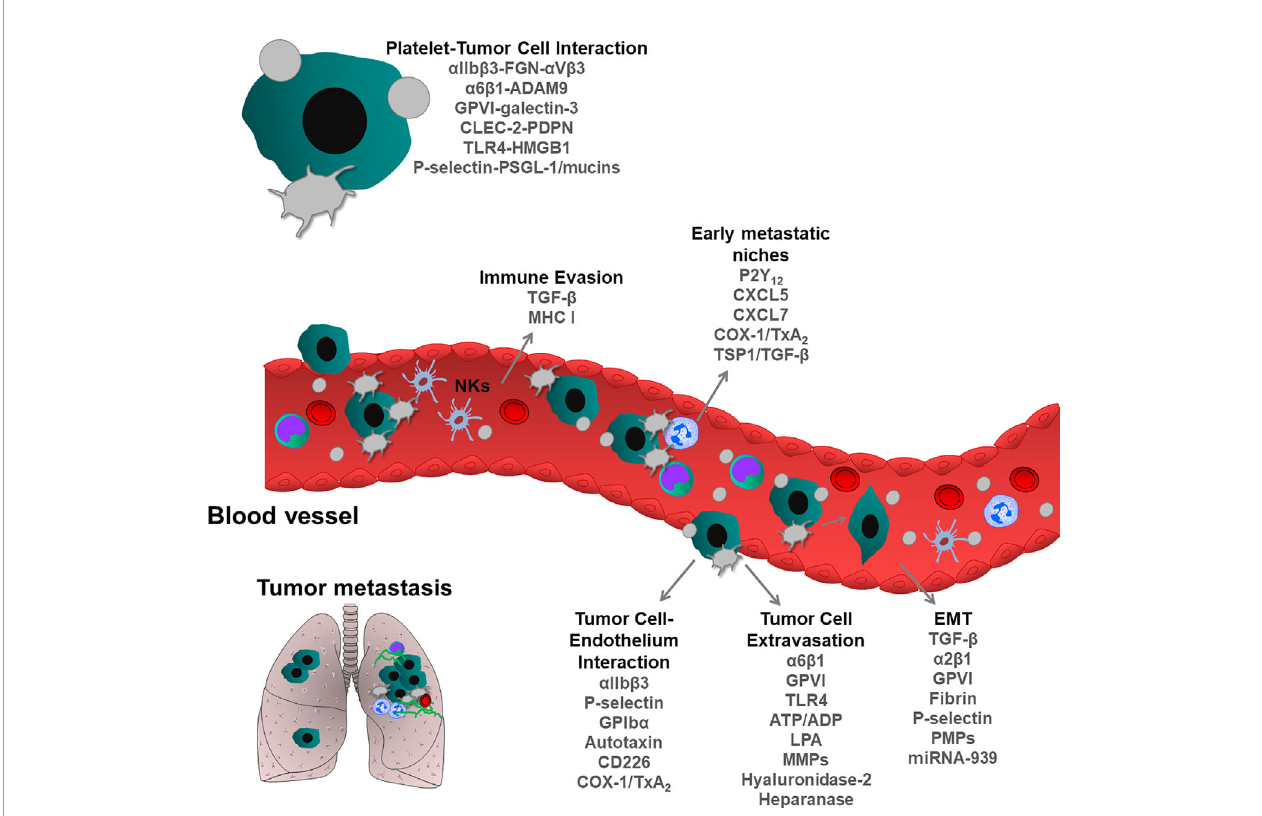
FIGURE 3 | Role of blood platelets in tumor metastasis. During metastatic spread, tumor cells enter into the blood circulation where they encounter tumor cells. Physical and functional interactions between platelets and tumor cells support metastatic dissemination of tumor cells and survival at distant metastatic organs. Platelets protect tumor cells from immune system surveillance, thereby enhancing the survival of circulating tumor cells. Following interactions with platelets, epithelial cancer cells can acquire mesenchymal phenotype, rapidly invading distant organs. Platelets form an active complex with in fl ammatory and tumor cells within the vasculature, thereby supporting the formation of metastatic niches. Platelets also can directly bridge tumor cells to the endothelium and induce their extravasation, leading to the seeding and proliferation of metastatic cells. As shown, each step of metastatic cascade is regulated by platelet-resident receptors and or other platelet-derived bioactive molecules, such as growth factors, cytokines, chemokines and